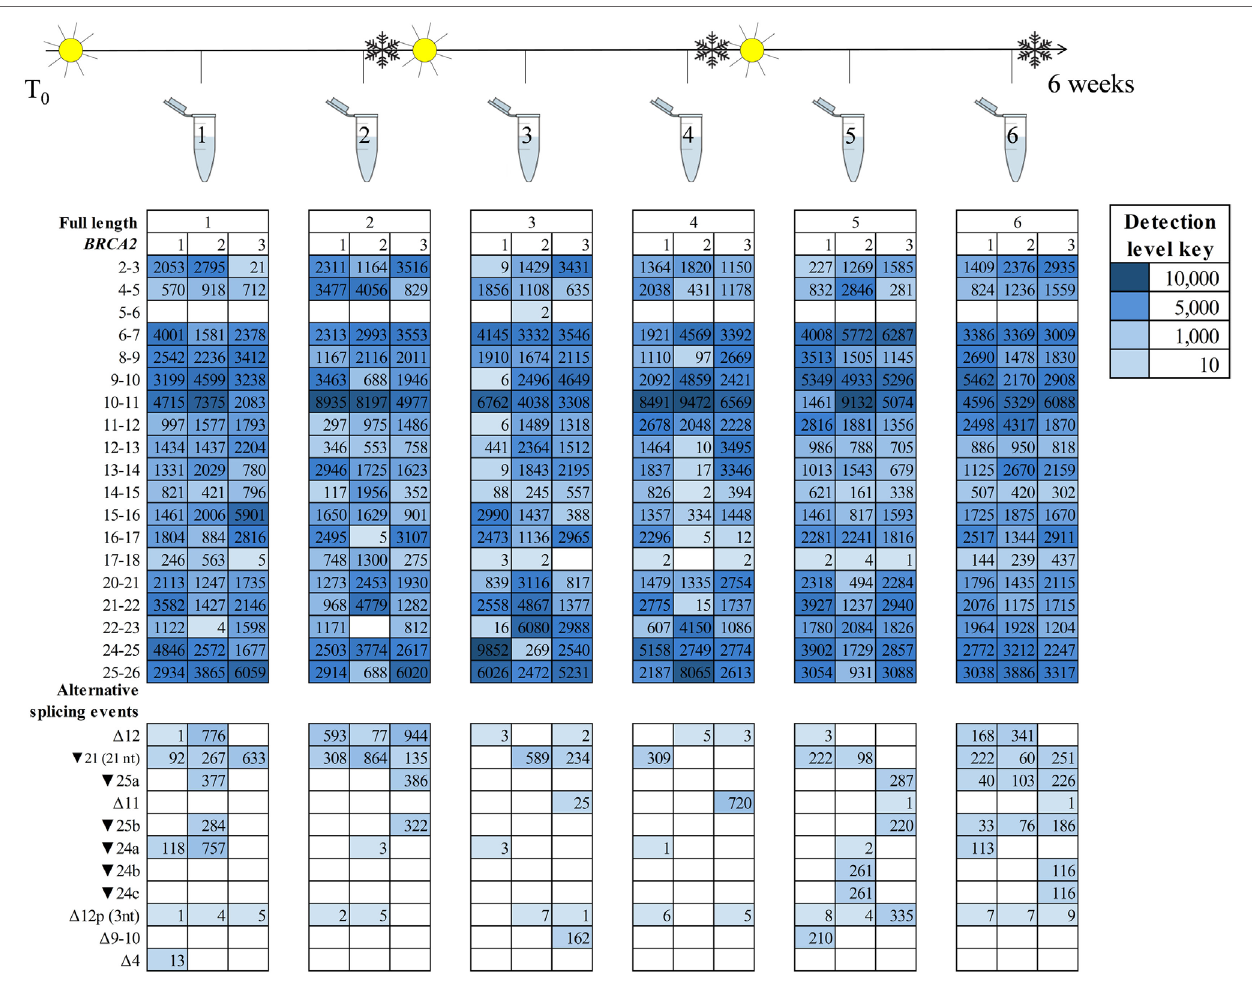
FigUre 4 | BRCA2 mRNA isoforms detected at six time points in an lymphoblastoid cell line (sample #7, Table S1 in Supplementary Material) treated with an nonsense-mediated decay inhibitor. A freeze–thaw process was undertaken after time points two and four. Three technical replicates are listed under each time